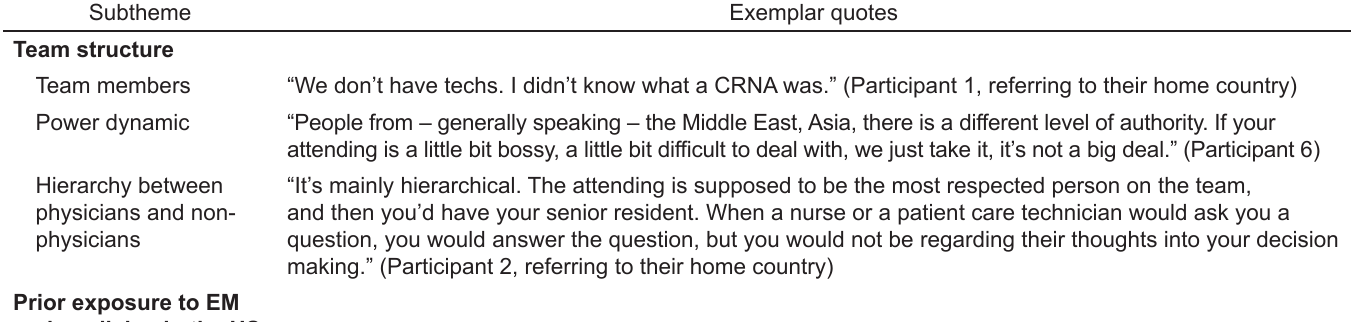
Table 3. Team-dynamic challenges perceived by non-US international medical graduates in emergency mnedicine residencies: system- based